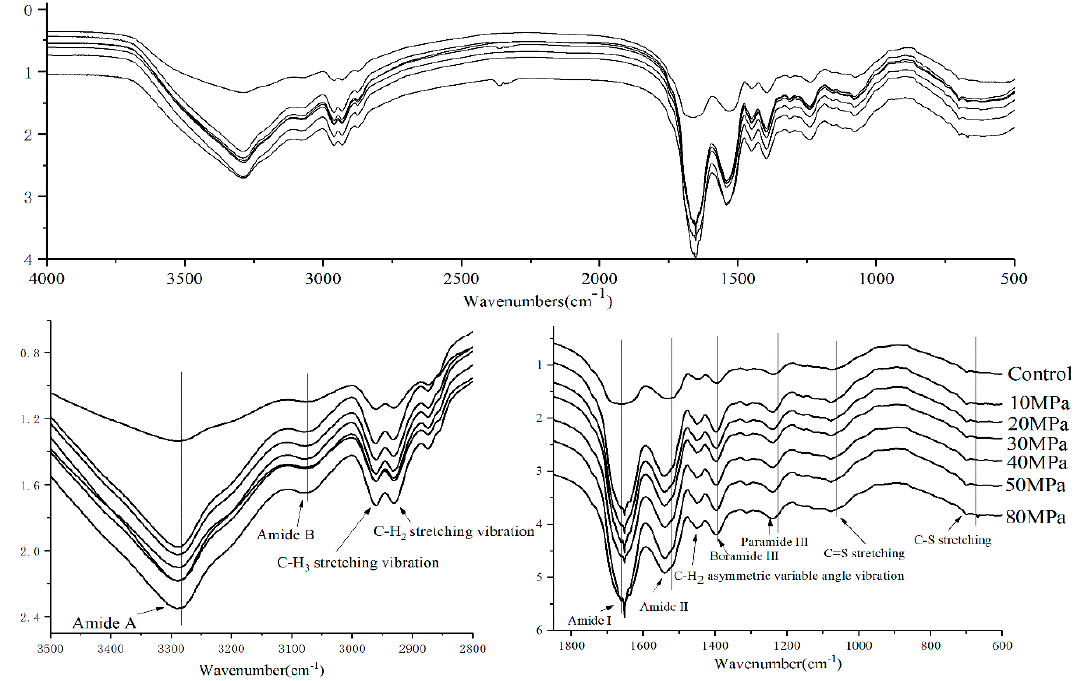
Figure 4. FTIR spectra of SPI after HPH treatment at different pressure levels from 4000 to 500 cm –1 .